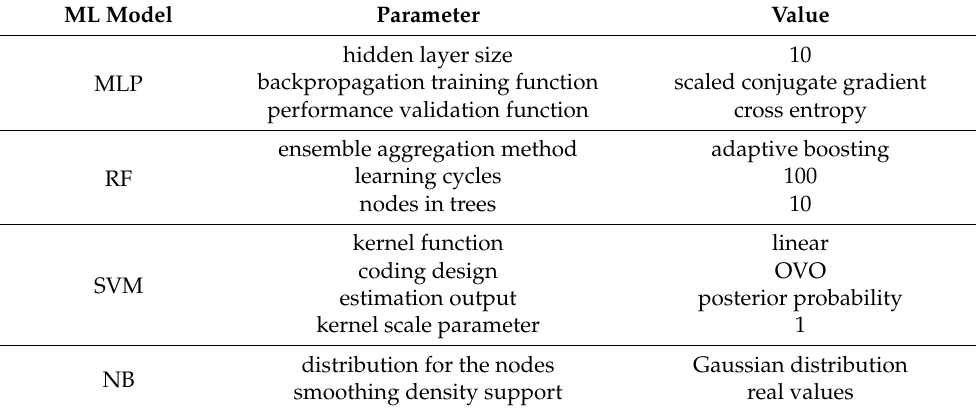
Table 2. Essential parameters of the ML models in data